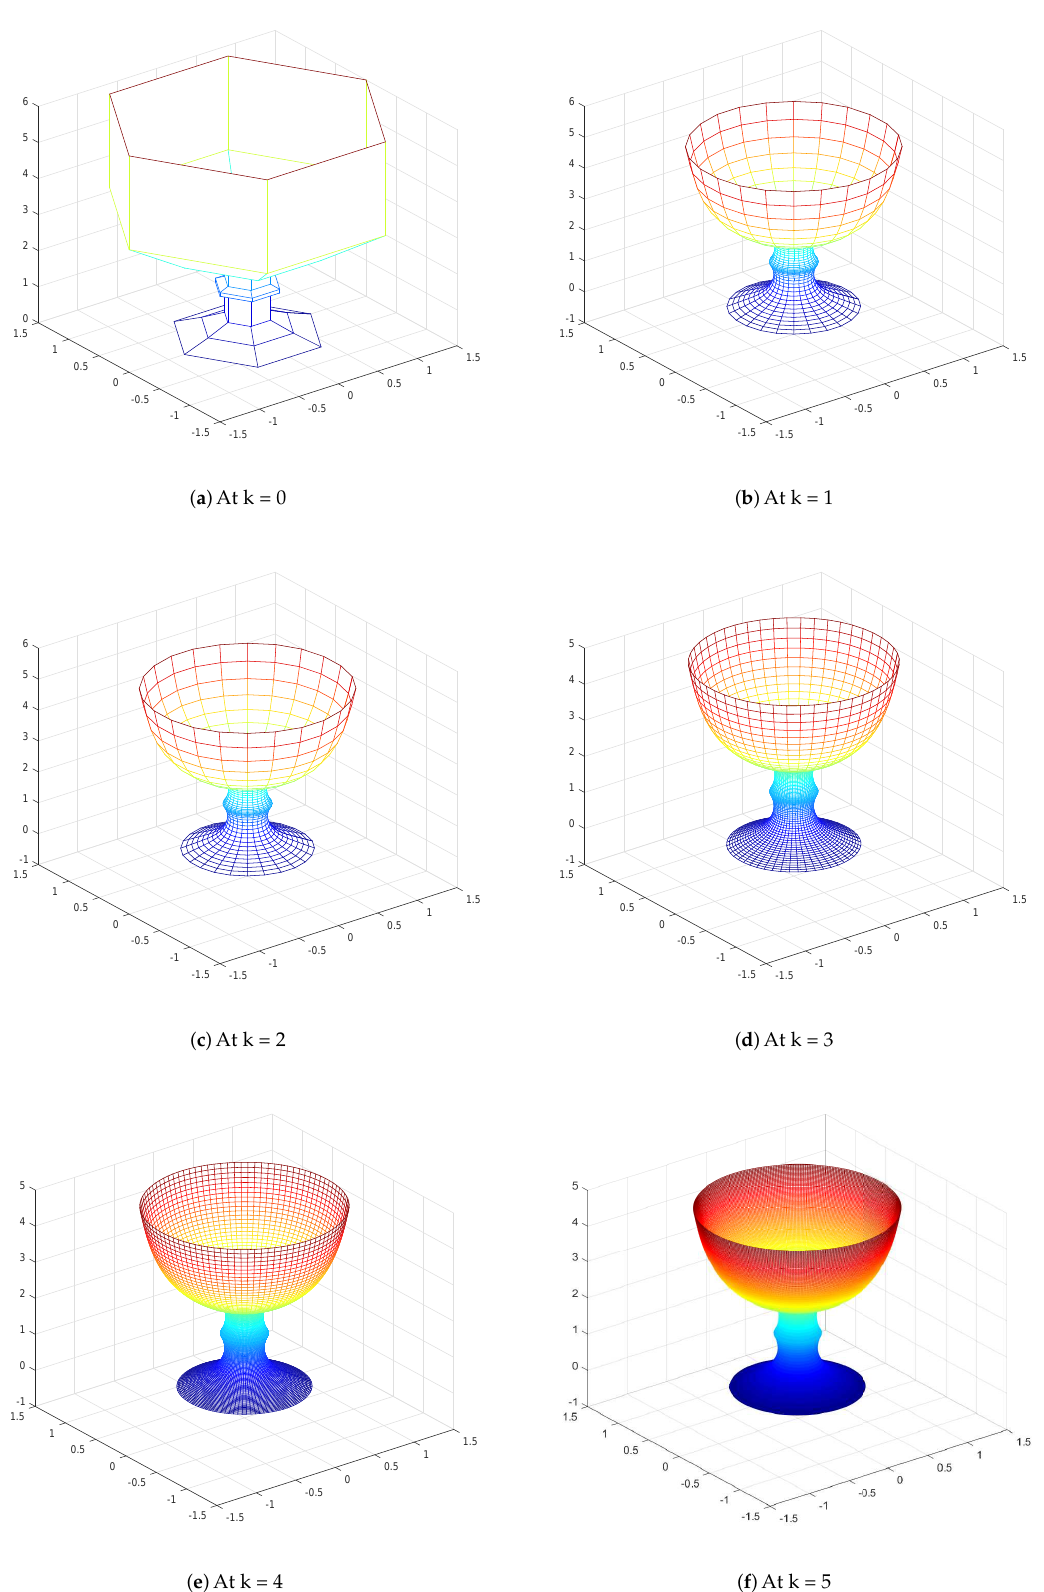
Figure 2. ( a ) The initial polygon; and ( b – f ) the results up to fifth subdivision